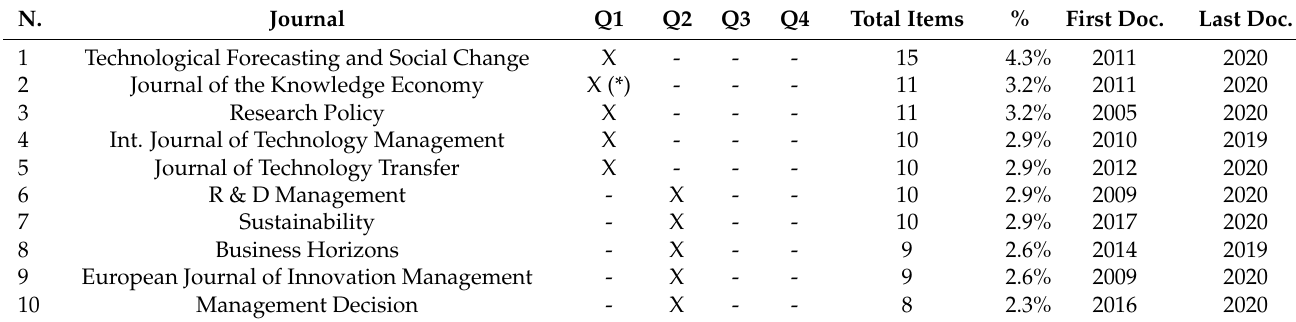
Table 3. Journals that have published on OI and university. Quartile 2019 and Total Items.